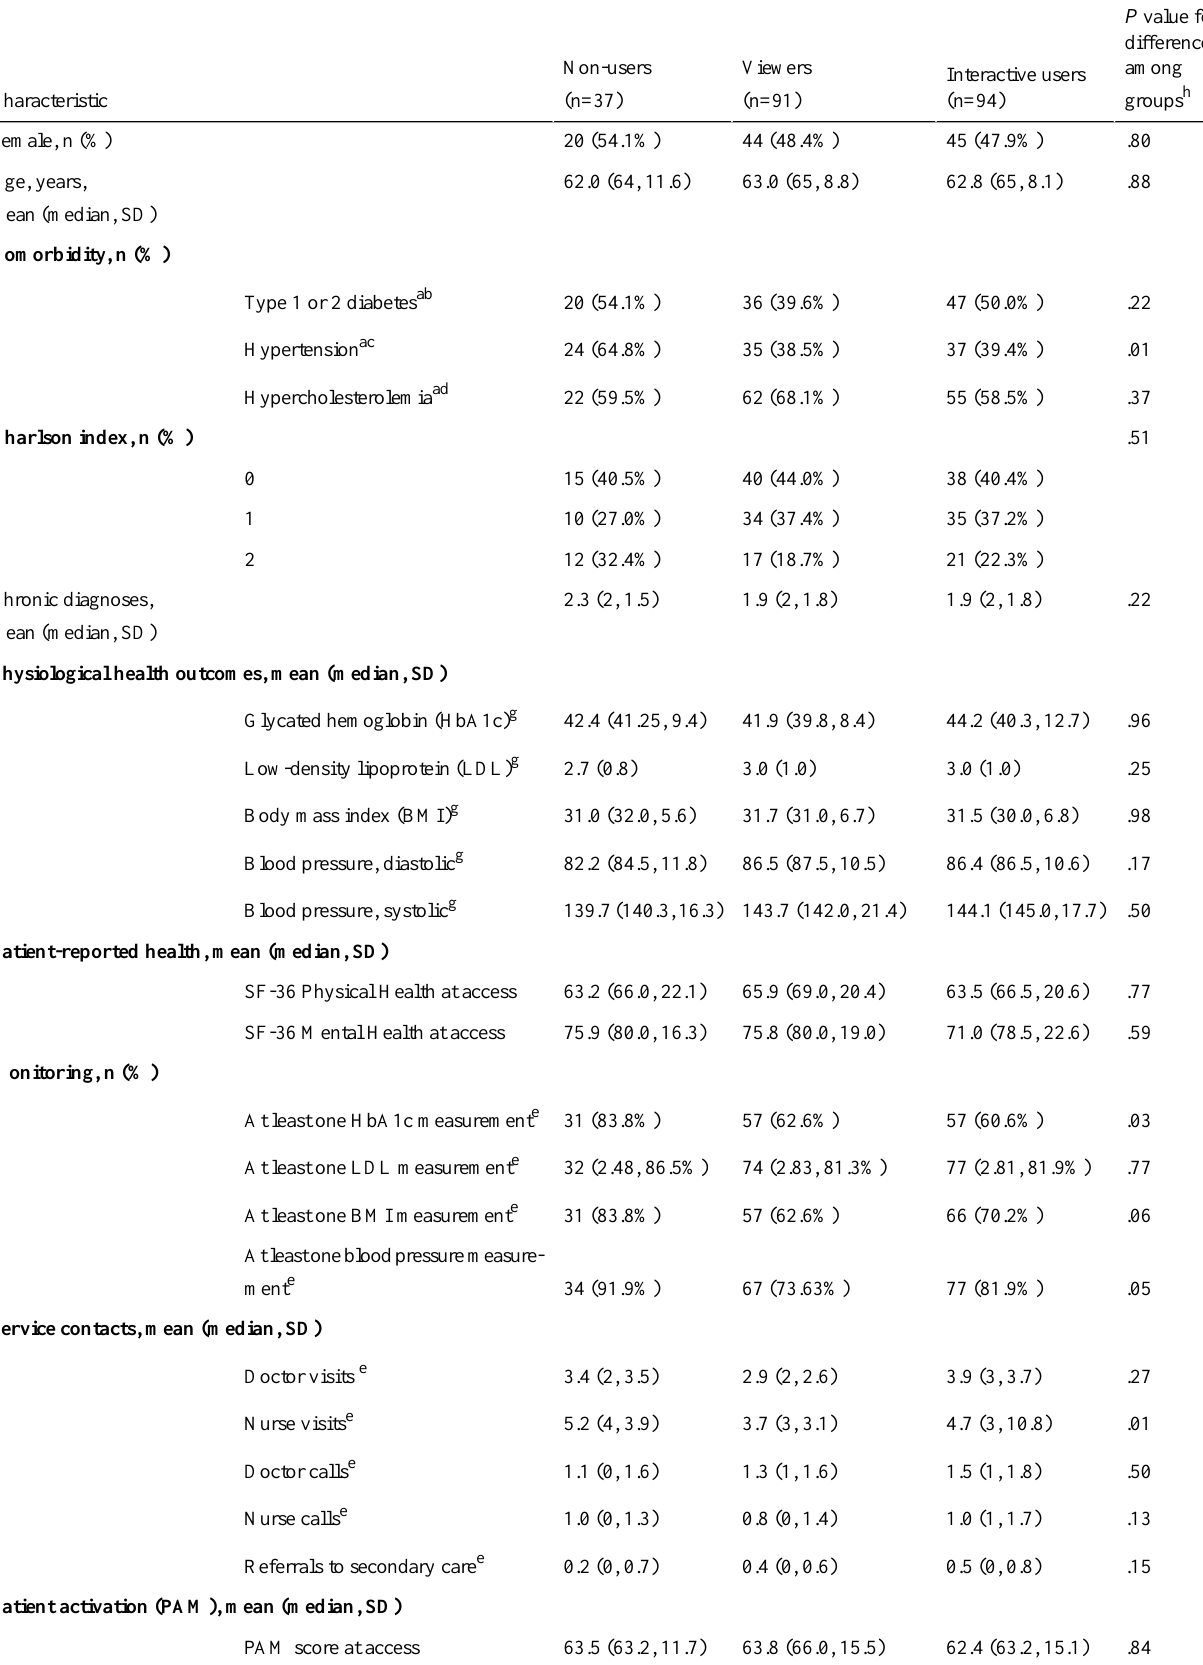
Table 3. Overall differences in patient characteristics among non-users, viewers, and interactive users.